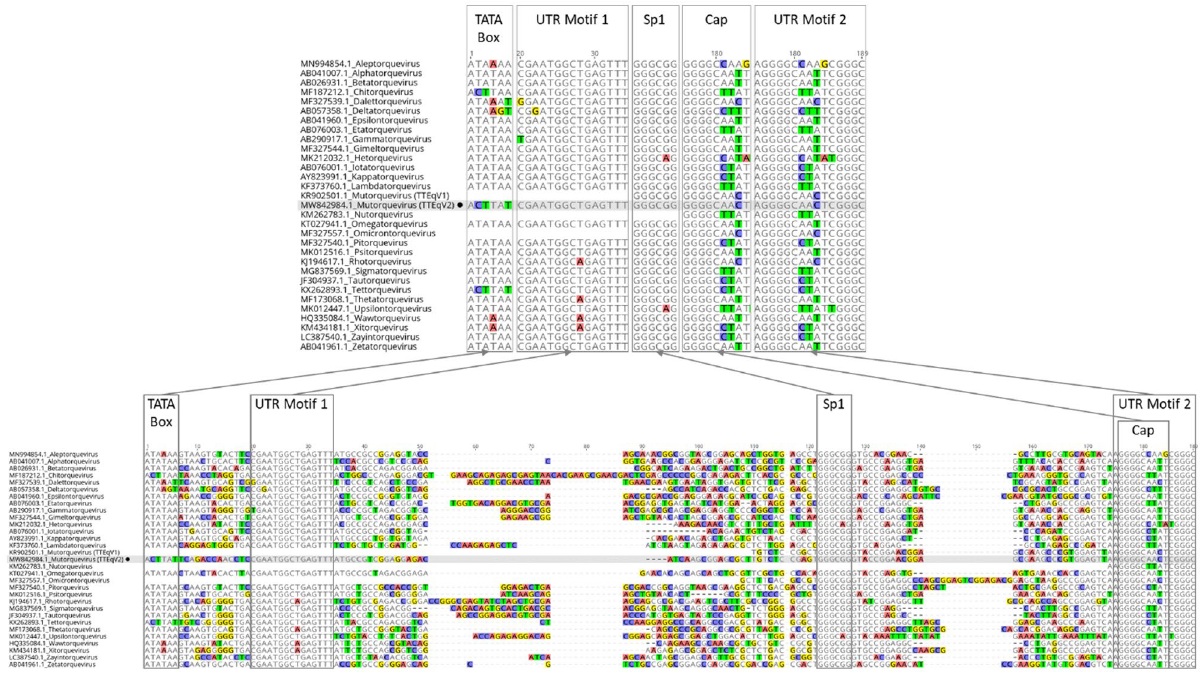
Figure 4. Nucleotide alignment of conserved region of the UTR from TTV genomes representing every currently recognized genus. Putative transcription factors and conserved motifs are labelled and outlined with boxes. Highlighted bases indicate those that differ from the majority consensus sequence. Each sequence is labelled with the NCBI accession number and genus. The novel TTEqV2 sequence is indicated with a black filled circle and shaded in gray for